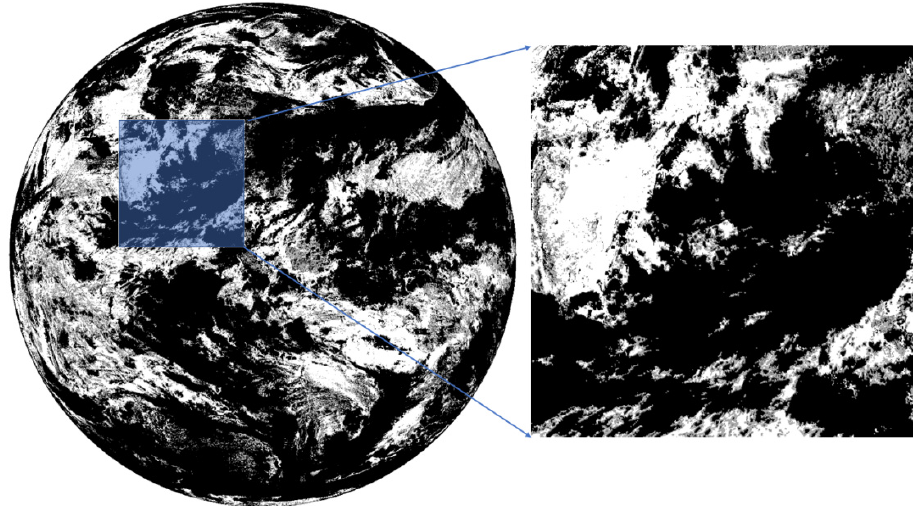
Figure 1. A binary image of FY-4A CLM.